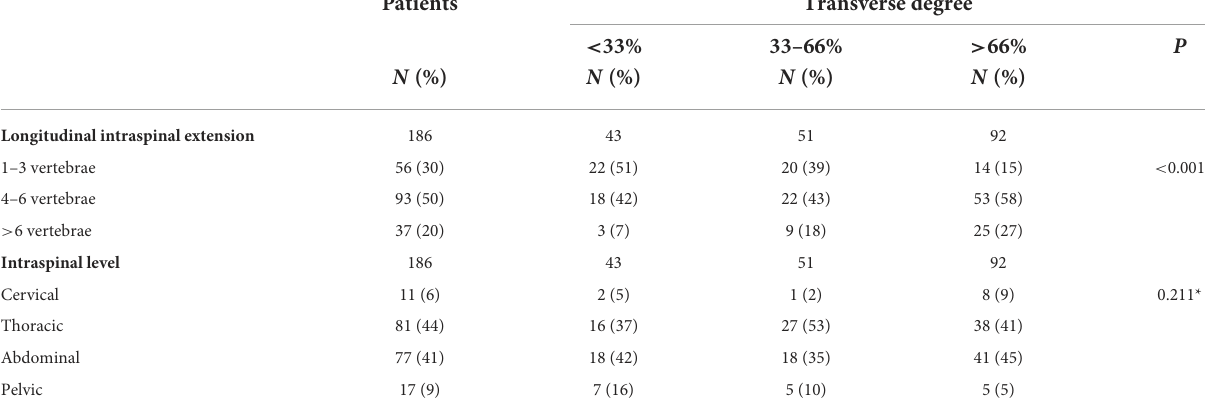
TABLE 4 Transverse degree of SCI in relation to longitudinal intraspinal extension and intraspinal